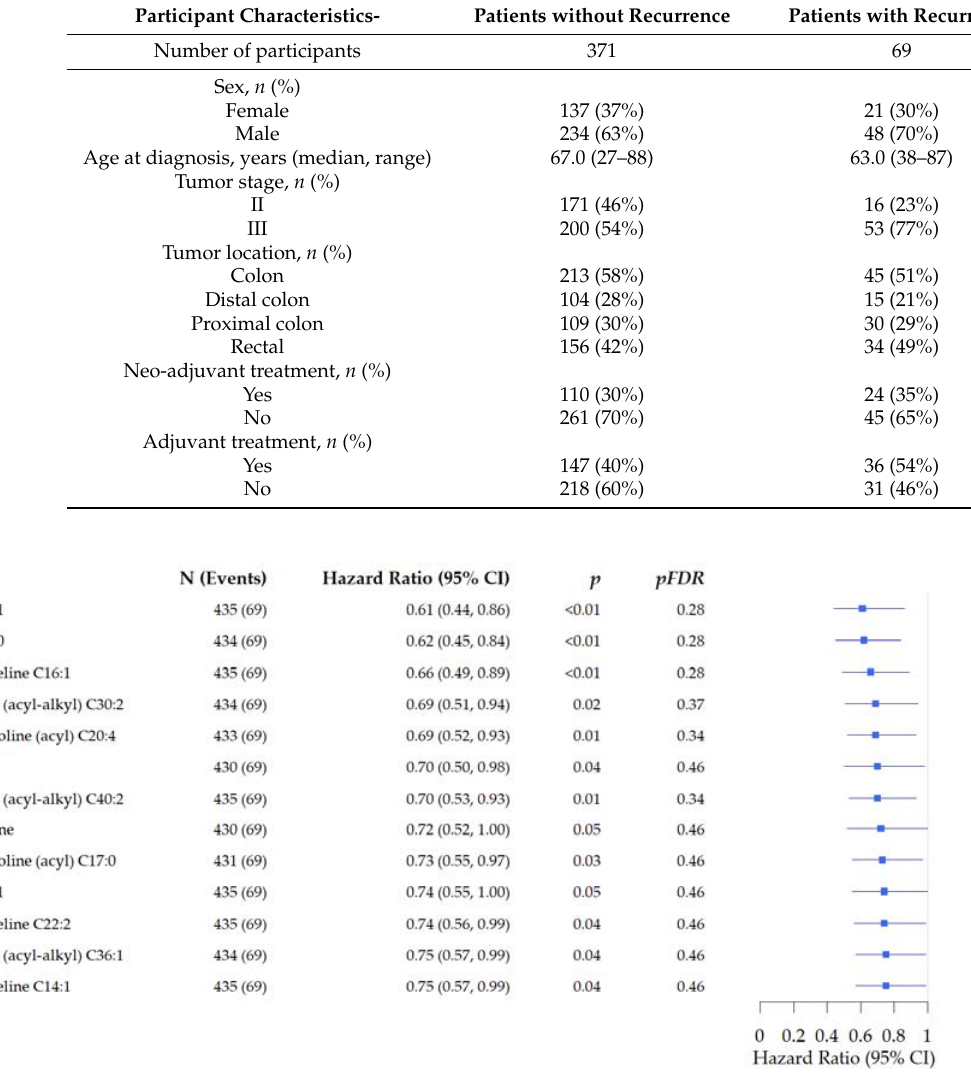
Table 2. Baseline characteristics of patients with and without a recurrence.